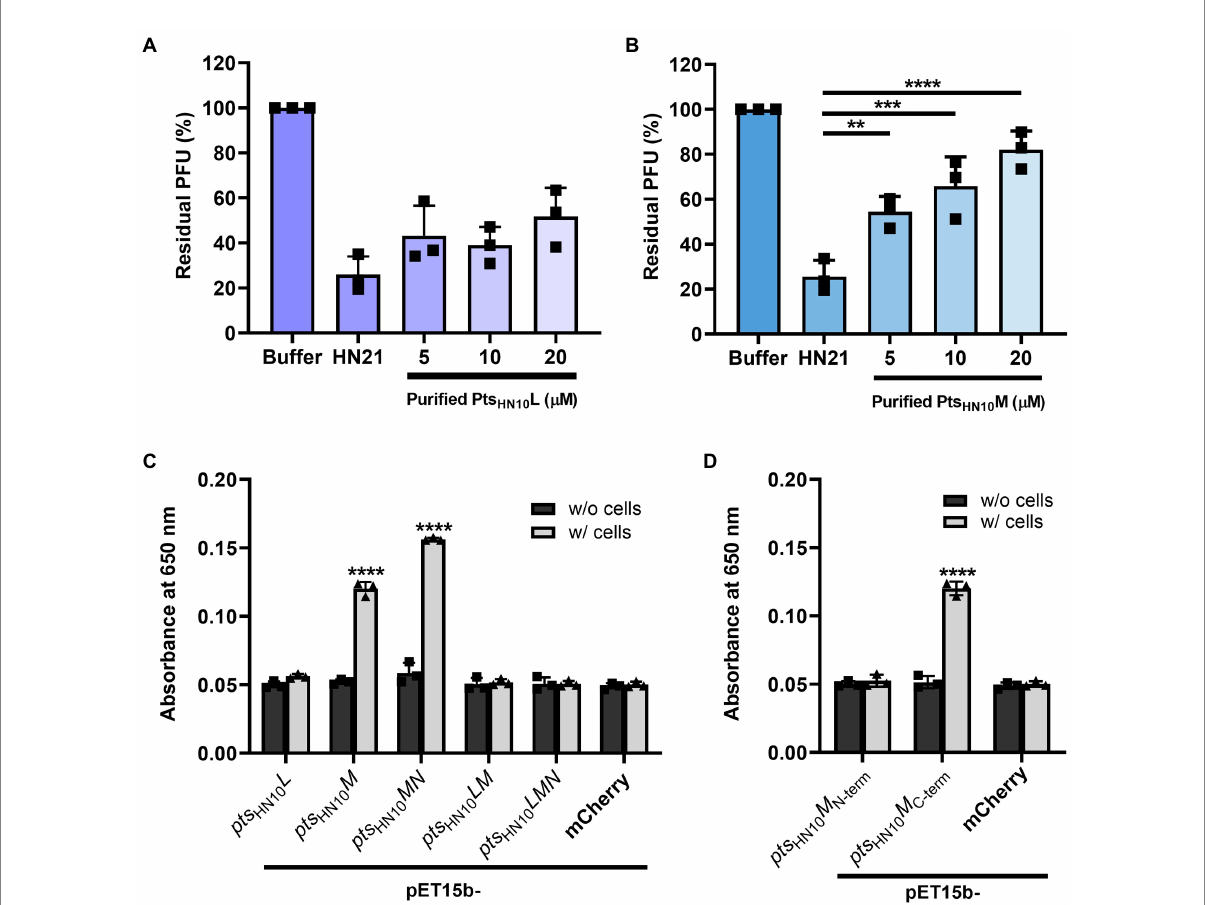
FIGURE 4 Functional analysis of putative RBPs. The bar graph represents the blockage of phage adsorption by (A) purified Pts HN10 L and (B) Pts HN10 M. Phage titers of each condition were compared with initial phage counts and displayed as percentages of residual plaque-forming unit (PFU). The standard deviation was calculated from three replicates. (C) The binding of putative RBPs and C. difficile was shown by enzyme-linked immunosorbent assay (ELISA) using purified proteins from five constructs at an absorbance of 650 nm. (D) The signal of ELISA using N-terminally and C-terminally truncated variants of PFts HN10 M and C. difficile HN21 strain. Purified mCherry with hexahistidine tag was used as a control for non-specific protein binding. The graphs show the mean and standard deviation from three replicates. The asterisk indicates the significant difference of